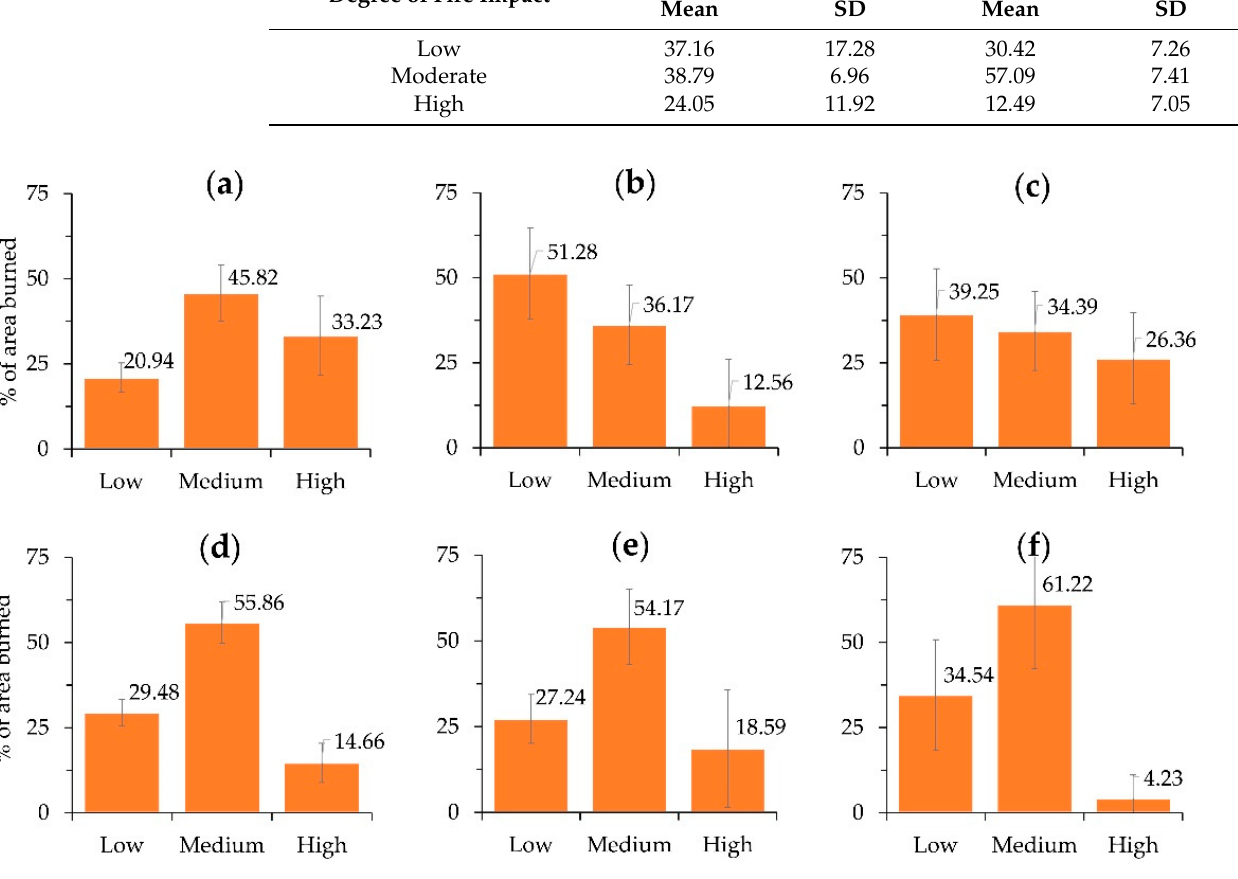
Figure 3. Severity/fire impacts (low, moderate, high) depending on dominant tree stands and types of vegetation: ( a ) larch close stands, ( b ) pine stands, ( c ) dark coniferous stands, ( e ) larch sparse, ( d ) Siberian dwarf pine ( Pinus pumila ), and ( f ) tundra vegetation. The proportion of severe fires varied according to the transition from dominant larch stands (33.2% of the area burned) to pine stands (12.6%) and dark coniferous stands (up to 26.4%) on average (Figure 3a–c). The proportion of severe fires was 2.0–2.5 times lower under conditions of vegetation types, dominated in the north (65 + N) of boreal forests of Siberia (18.6%, 14.7%, and 4.2%, in Pinus pumila , larch sparse, and tundra, respectively) (Figure 3d–f). On average, stand-replacement fires (in terms of the highest dNBR) varied from 7–12% for the category of small-size fire to 15–20% for large-scale fire. At the same time, medium-size fire (2 thousand hectares < S < 20 thousand hectares) was accompanied by the highest degree of fire damage in 25–35% of the total area burned. Hence,